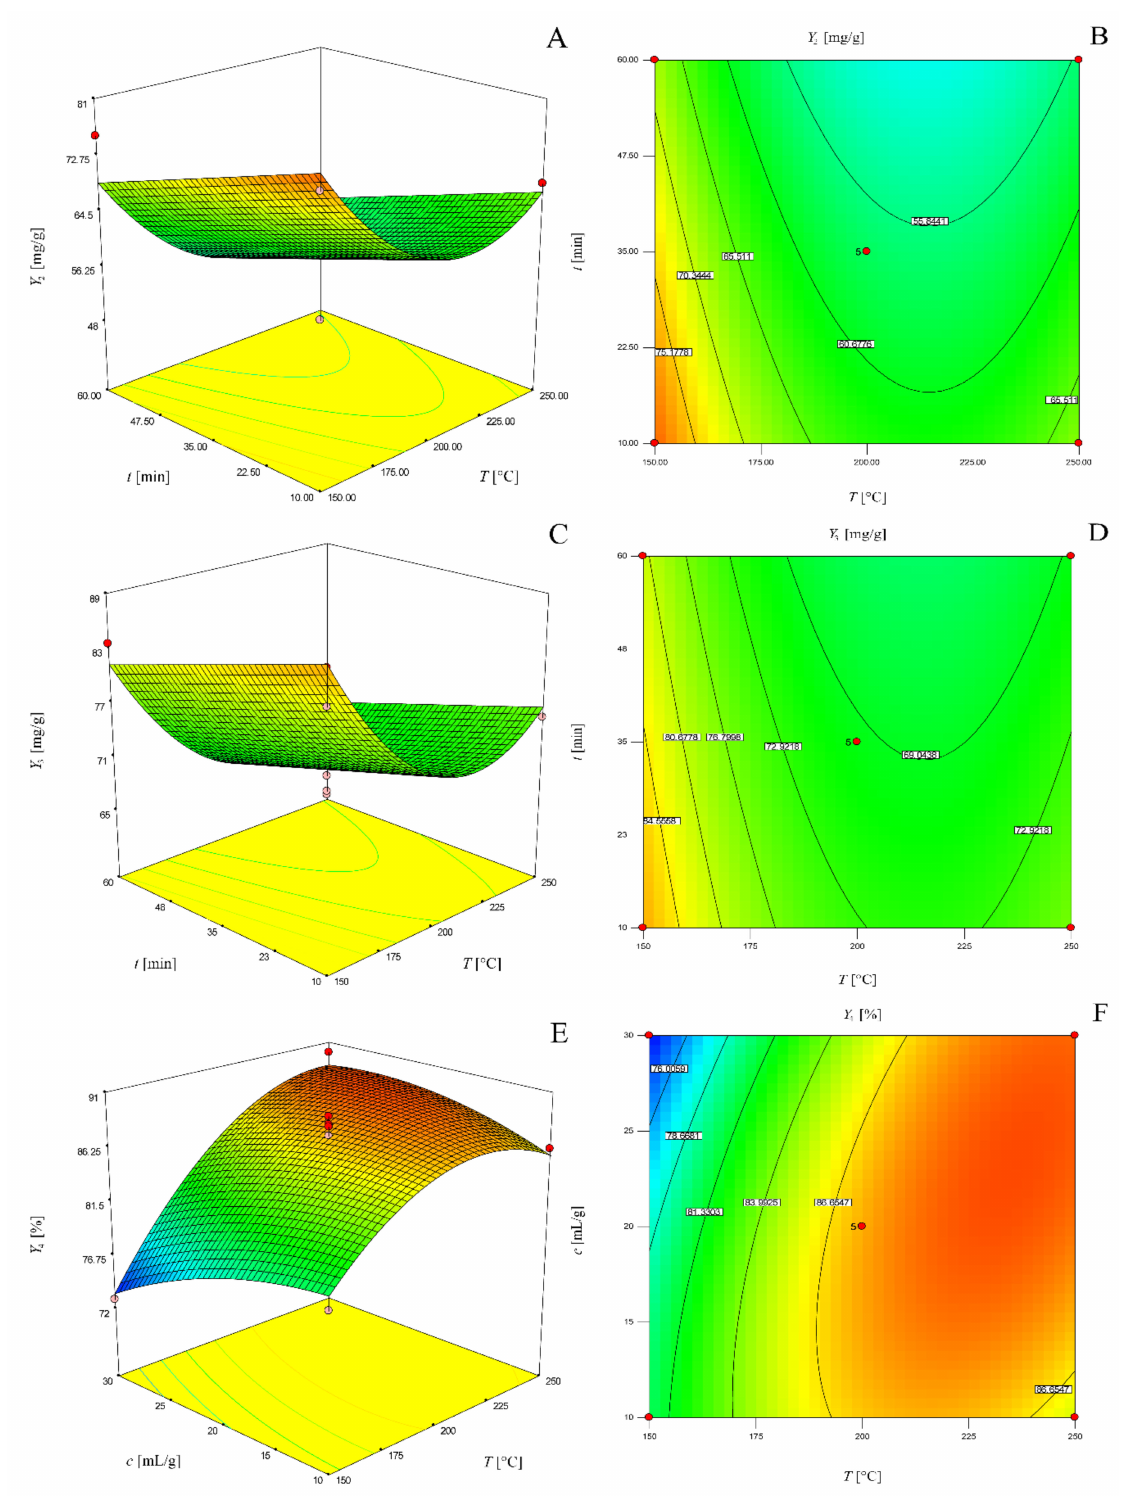
Figure 2. Three-dimensional response surface ( a ) and two-dimensional contour plot ( b ) of the model for determination of total phenol content for solvent-solid ratio of 20 mL / g; three-dimensional response surface ( c ) and two-dimensional contour plot ( d ) of the model for determination of total tannin content for solvent-solid ratio of 20 mL / g; three-dimensional response surface ( e ) and two-dimensional contour plot ( f ) of the model for determination of antioxidant activity for 35